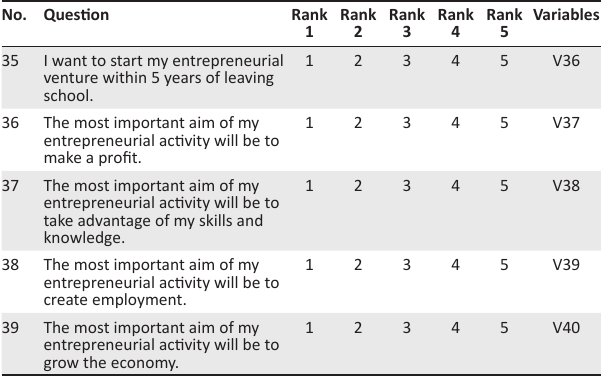
TABLE 12: Questions relating to entrepreneurial activity.